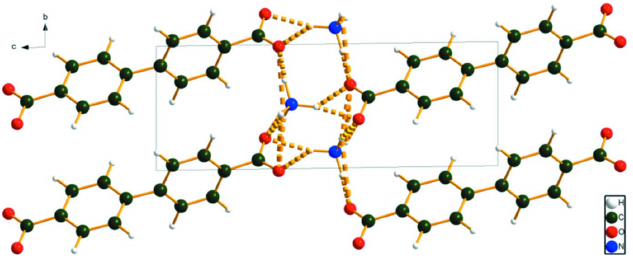
Figure 11 Crystal structure of (NH 4 ) 2 (BPDC), viewed down the a -axis. Image generated using DIAMOND (Crystal Impact, 2022). The hydrogen bonds are illustrated by heavy dashed lines.